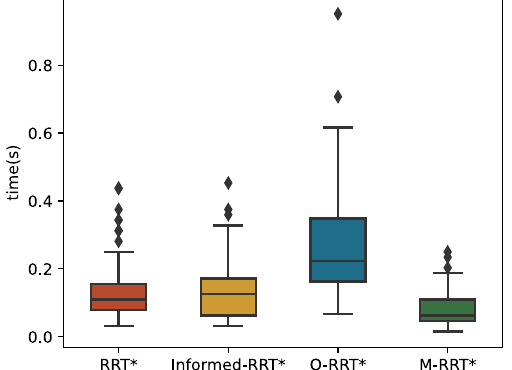
Figure 10. t init in the regular environment.